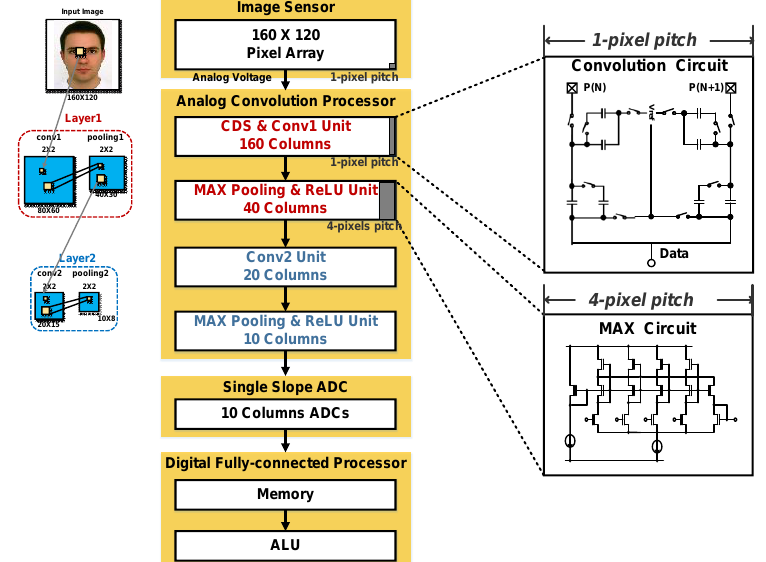
Figure 4. Overall architecture of the proposed Complementary Metal Oxide Semiconductor (CMOS) image sensor (CIS).